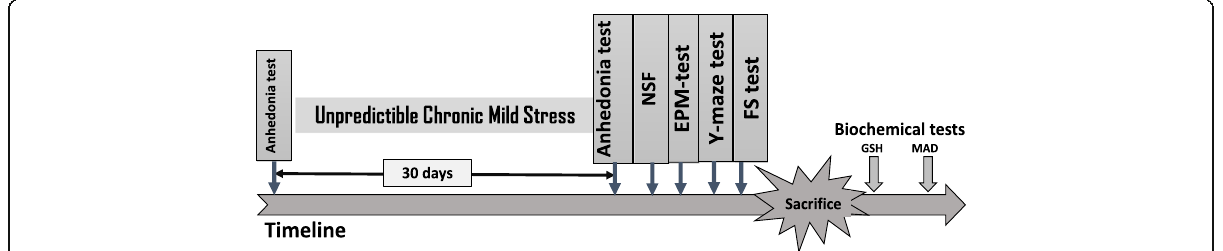
Fig. 1 Experimental design. Baseline sucrose-preference was assessed before beginning the chronic unpredictable mild stress (CUMS). Only the animals having reduced the preference for sucrose by more than 50% were selected for the next steps of the experiment. F. sycomorus extract or imipramine was administered daily by gavage during both the 30 days stress sessions and behavior tests. At the end of the stress period, behavioral tests were carried out in a growing of stress order. The same set of animals was used for all the behavioral tests: day 31 for NSF, EPM, Y-maze and days 32, 33 for FST. Following the FS test, the mice were sacrificed for biochemical